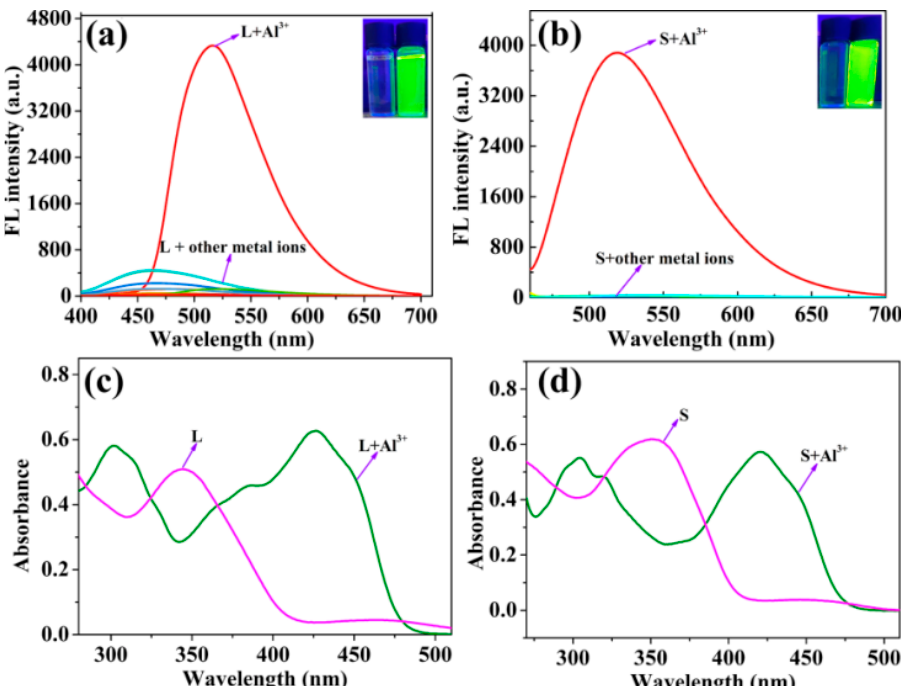
Figure 1. Fluorescence spectra of probe L ( a ) and S ( b ) (5.0 × 10 − 5 mol/L) with various metal ions (Al 3+ , Mg 2+ , Pb 2+ , Zn 2+ , Cu 2+ , Mn 2+ , Co 2+ , Cr 3+ , Hg 2+ , Cd 2+ , Ni 2+ and Fe 3+ , 2.5 × 10 − 4 mol/L) in DMSO/H 2 O solution, UV spectrum of L ( c ) and S ( d ) solutions after adding Al 3+ ions.